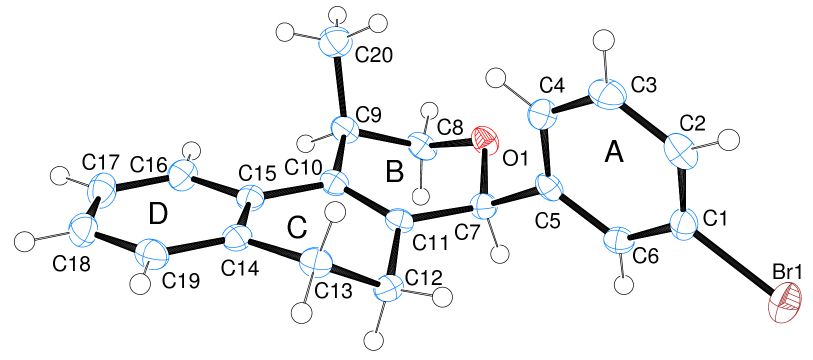
Figure 1. ORTEP-3 view of 7k showing the atom labeling, configuration of the chiral atoms and 50% probability ellipsoids. H atoms are shown as spheres of arbitrary